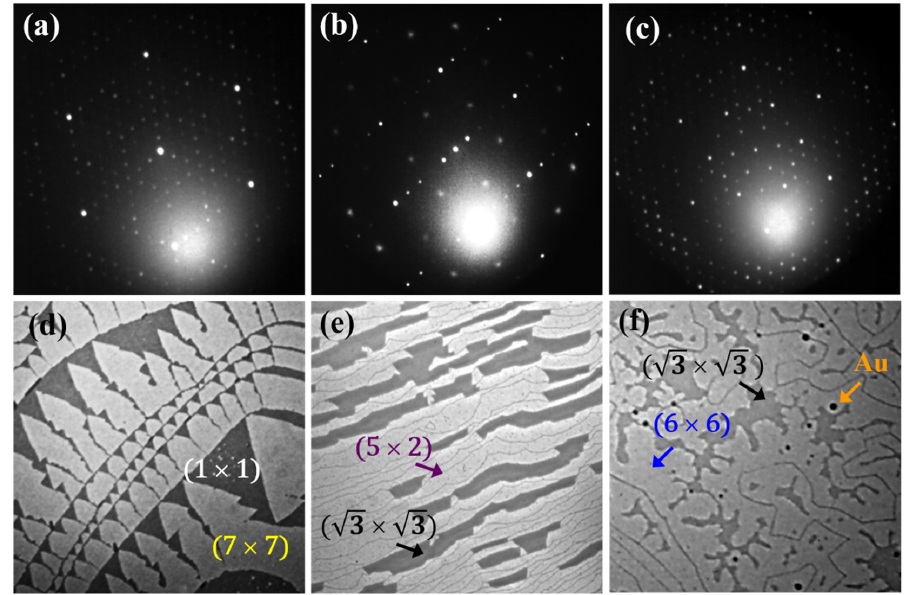
Figure 1. LEED patterns and corresponding LEEM images of: Si(111)-(7 × 7) surface ( a , d ), Si(111)-(5 × 2) coexisting with (√3 × √3) ( b , e ) and Si(111)-(6 × 6) coexisting with (√3 × √3) ( c , f ). LEED patterns were taken with E = 45.7 eV, whereas LEEM images (5 5 μm 2 ) were recorded with E = 0.2 eV ( d ), E = 7.2 eV ( e ), E = 1 eV ( f ), respectively.